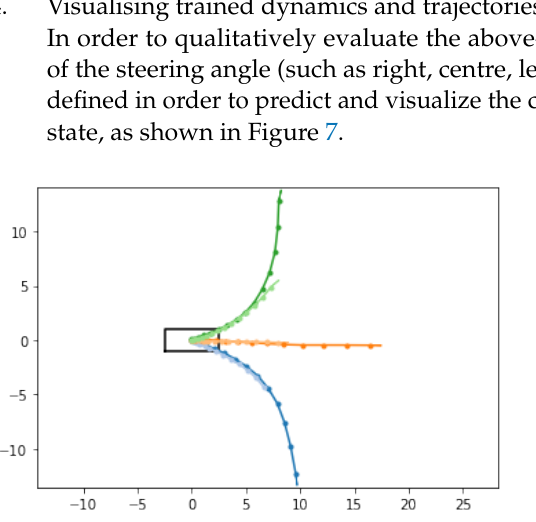
Figure 7. Left, right, and centre trajectories of ego vehicle visualised after training in the X,Y plane.